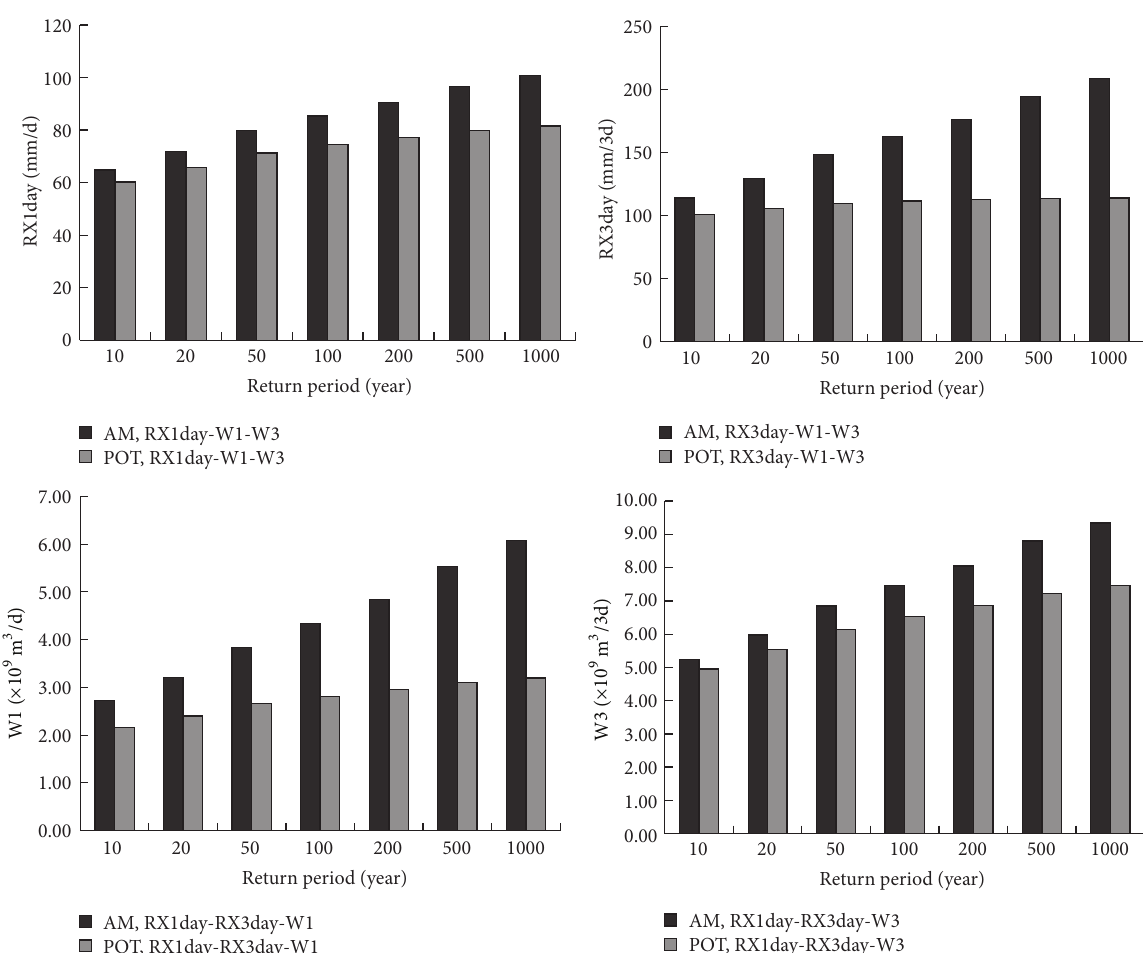
Figure 5: Extreme precipitation and flood discharge estimated via 3D joint distributions under a range of return periods.